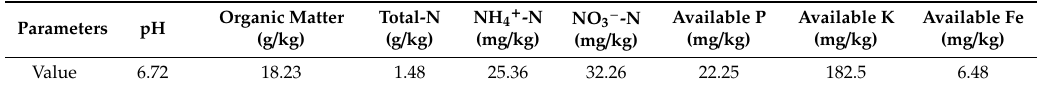
Table 1. Experiment soil